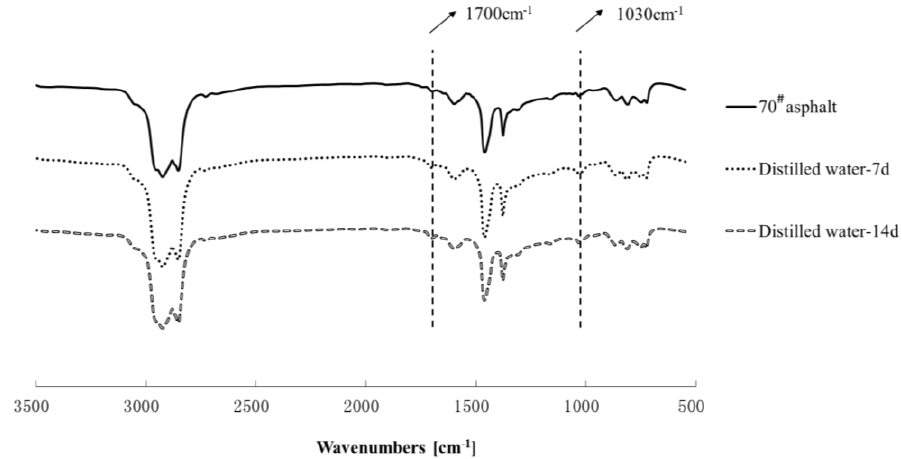
Figure 6. FTIR spectra of the 70 # asphalt before and after distilled water aging.